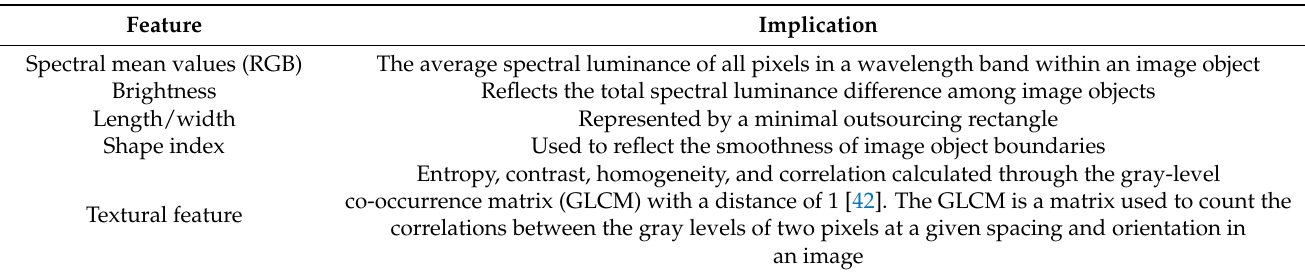
Table 2. List of features derived from the UAV digital